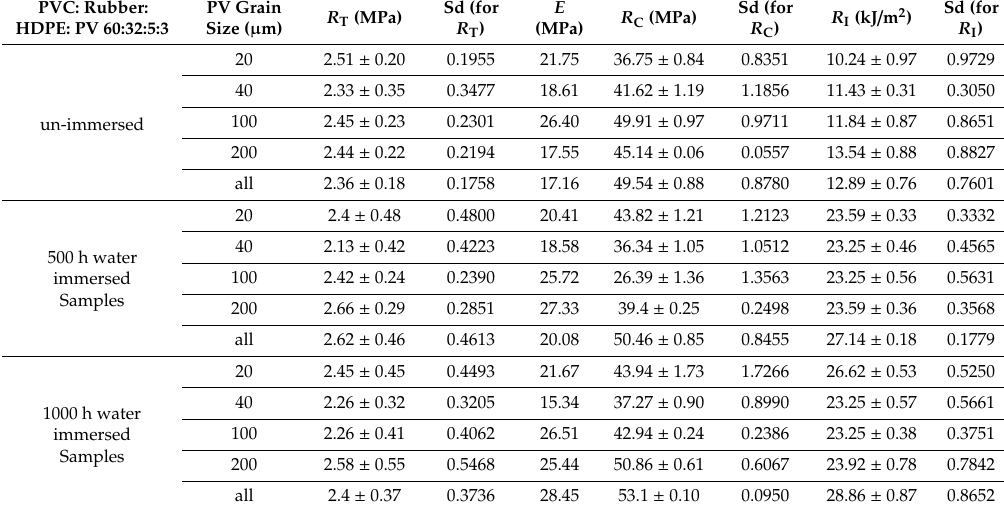
Table 3. Mechanical properties of hybrid composites with low Si-PV content.